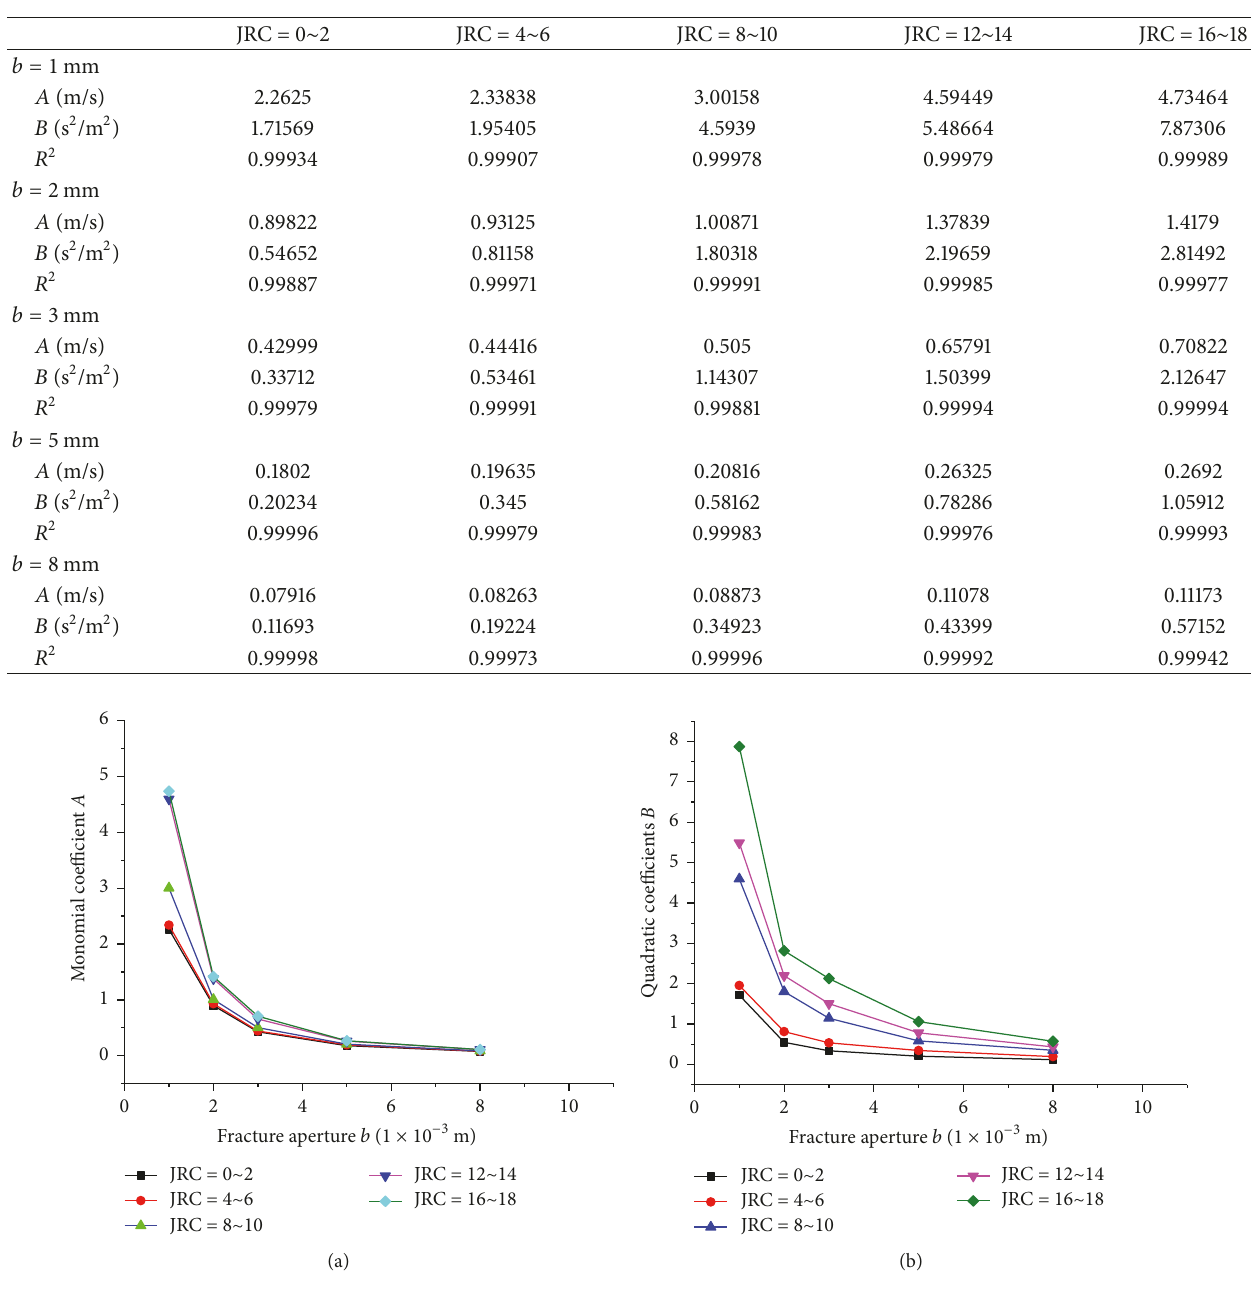
Table 2: Fitting results of hydraulic gradient and velocity Forchheimer of rough fracture under different width and JRC.